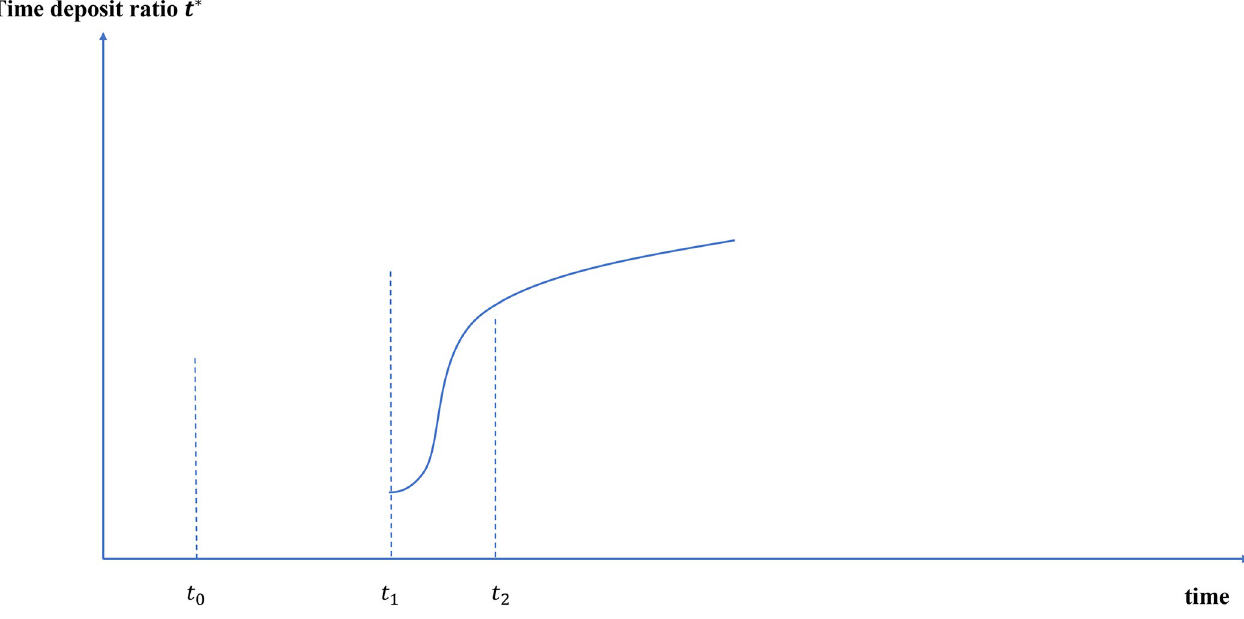
Fig 11. Path changes of time deposit ratio after e-CNY issuance.